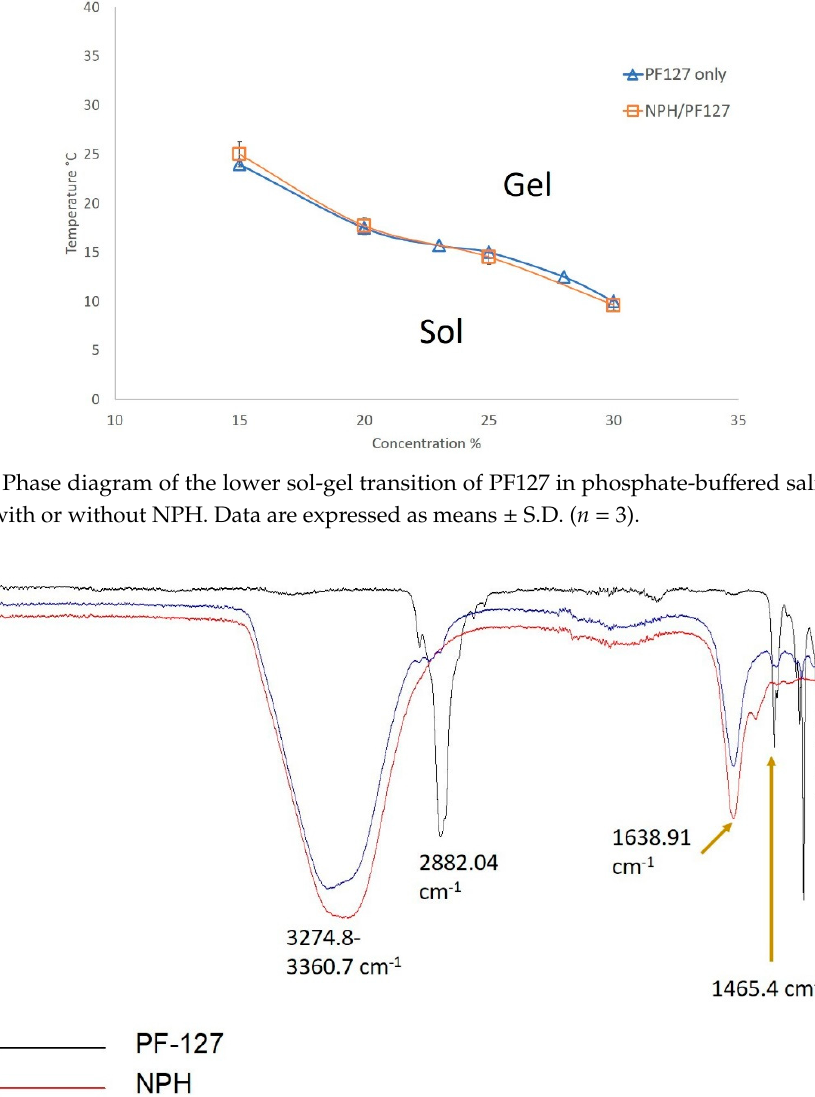
Figure 2. Phase diagram of the lower sol-gel transition of PF127 in phosphate-buffered saline (PBS) (pH 7.4) with or without NPH. Data are expressed as means ± S.D. ( n = 3).